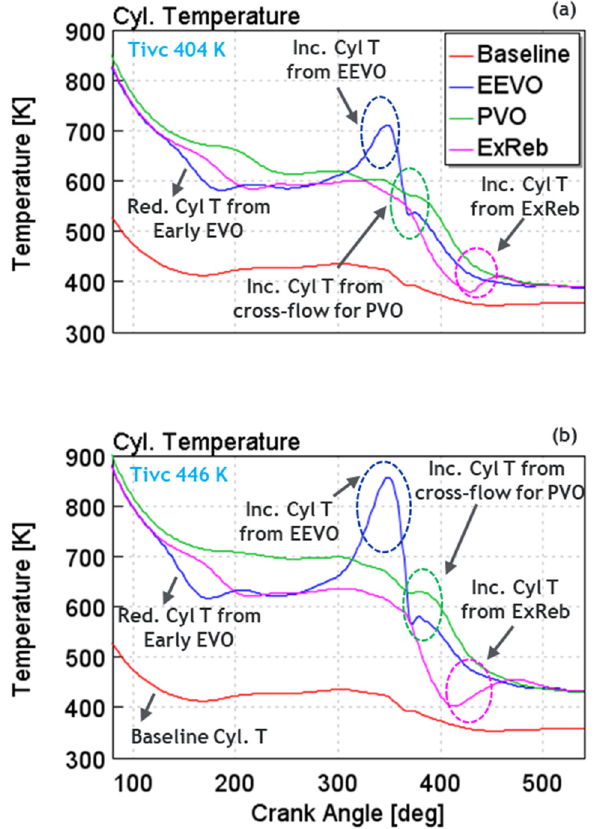
Figure 11. In-cylinder temperatures comparison among the three strategies for Tivc ( a ) 404 and ( b ) ( b ) 446 K at 446 K at B10.